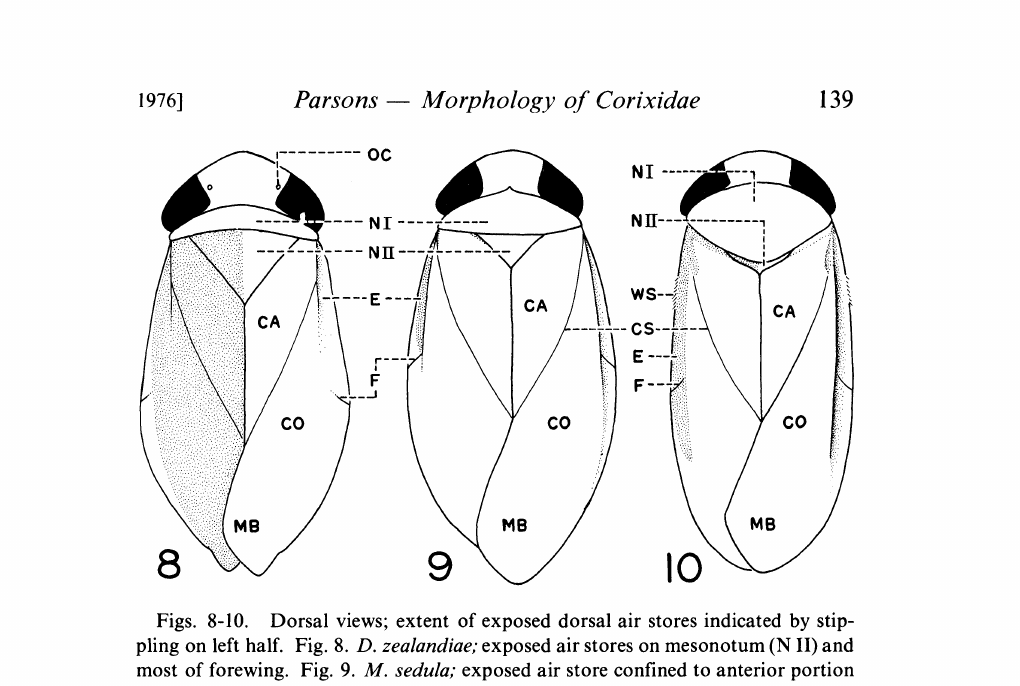
Figs. 8-10. Dorsal views; extent of exposed dorsal air stores indicated by stip- pling on left half. Fig. 8. D. zealandiae; exposed air stores on mesonotum (NII) and most of forewing. Fig. 9. M. sedula; exposed air store confined to anterior portion of embolium (E) and anteriormost part of claval suture (CS). Air on mesonotum is concealed by pronotum (N I). Fig. 10. H. interrupta; exposed air store on